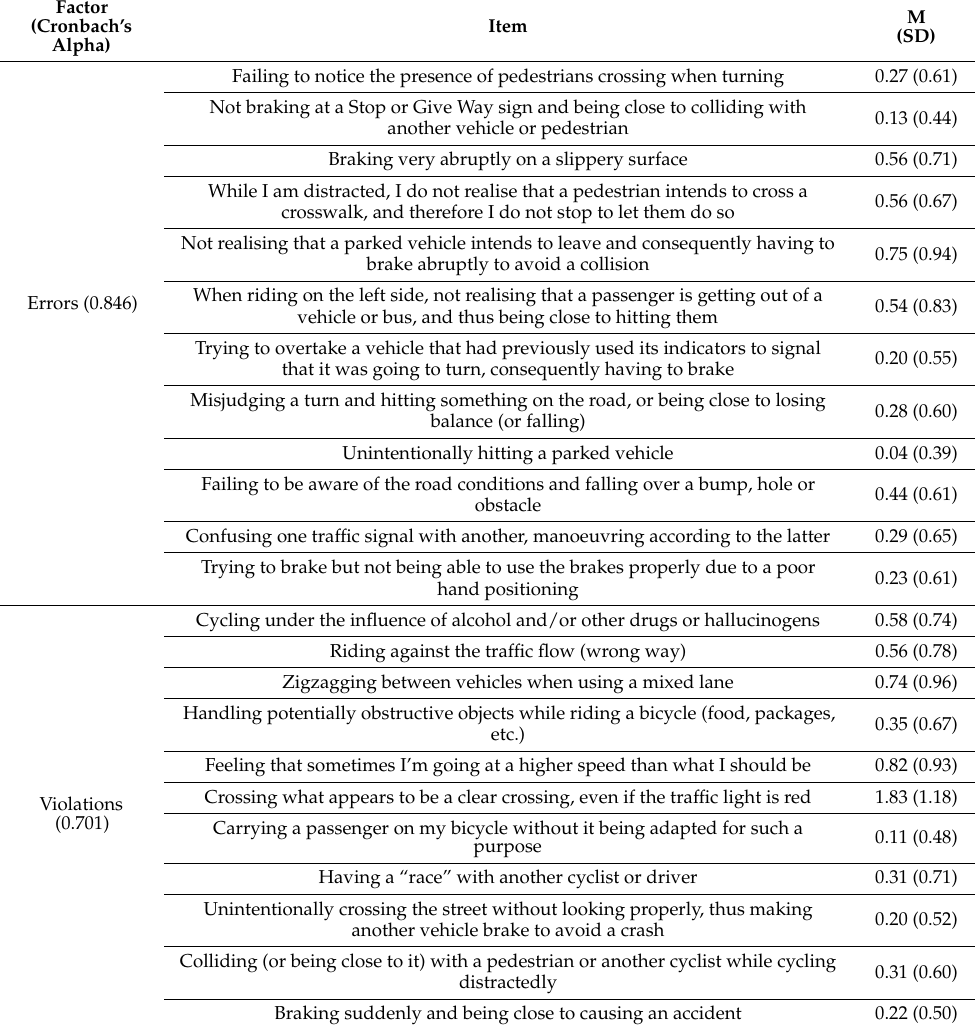
Table 1. Cycling behaviour questionnaire (CBQ) item